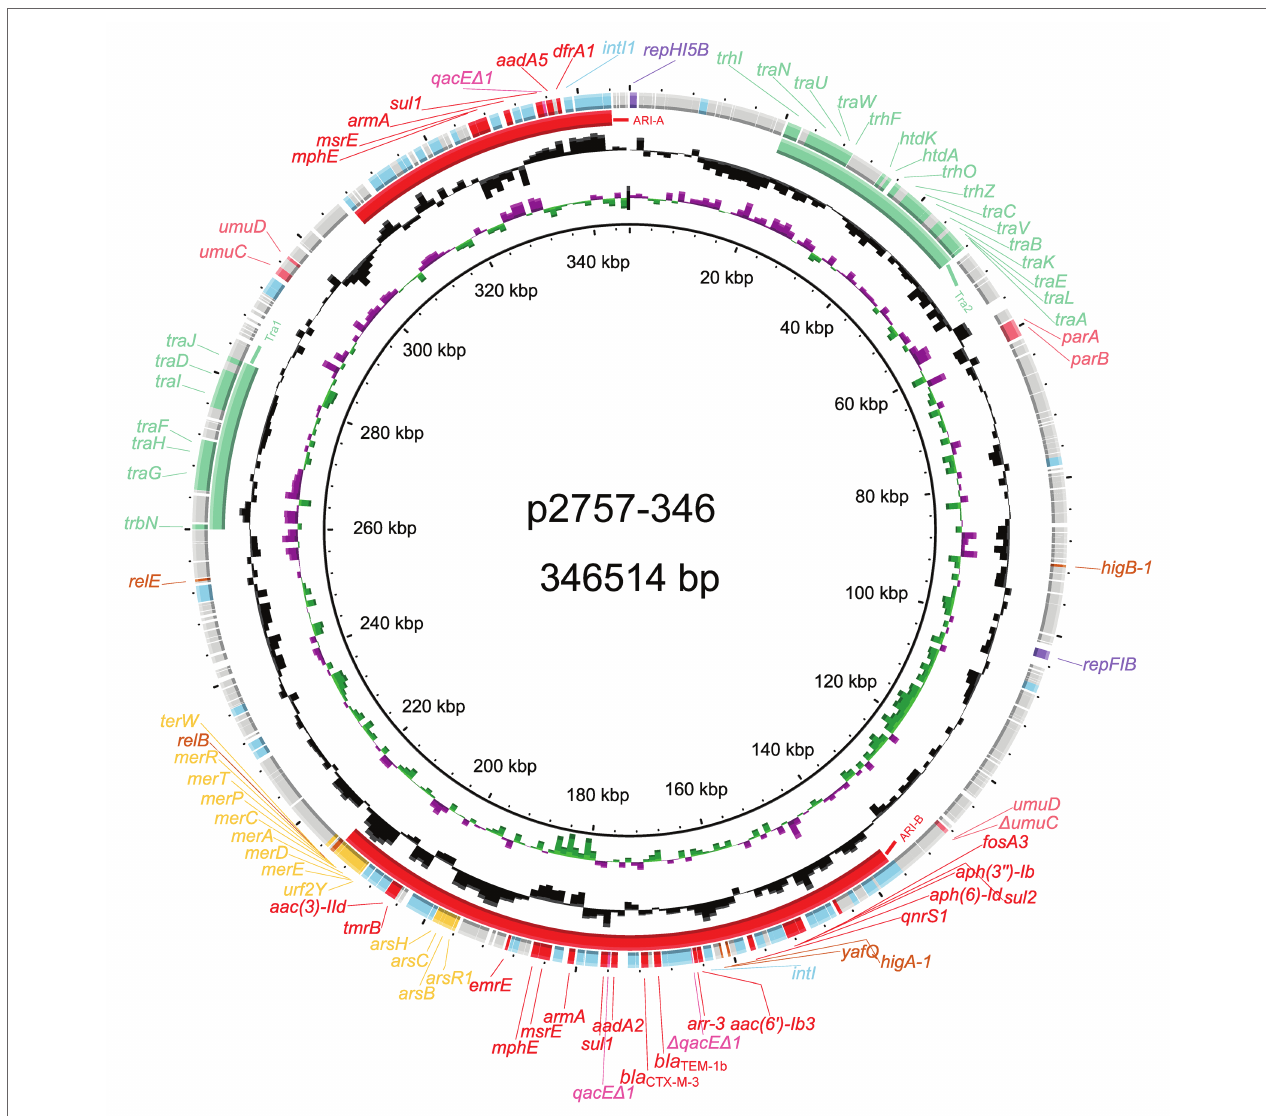
FIGURE 1 | Schematic diagram of the p2757-346 plasmid. The various colors indicate different gene functions, including replication (in purple), transfer (in green), maintenance (in pink), and resistance (in red), and mobile elements (in blue). The circles show (from outside to inside) predicted coding sequences, the GC content, the GC skew, and the scale (in